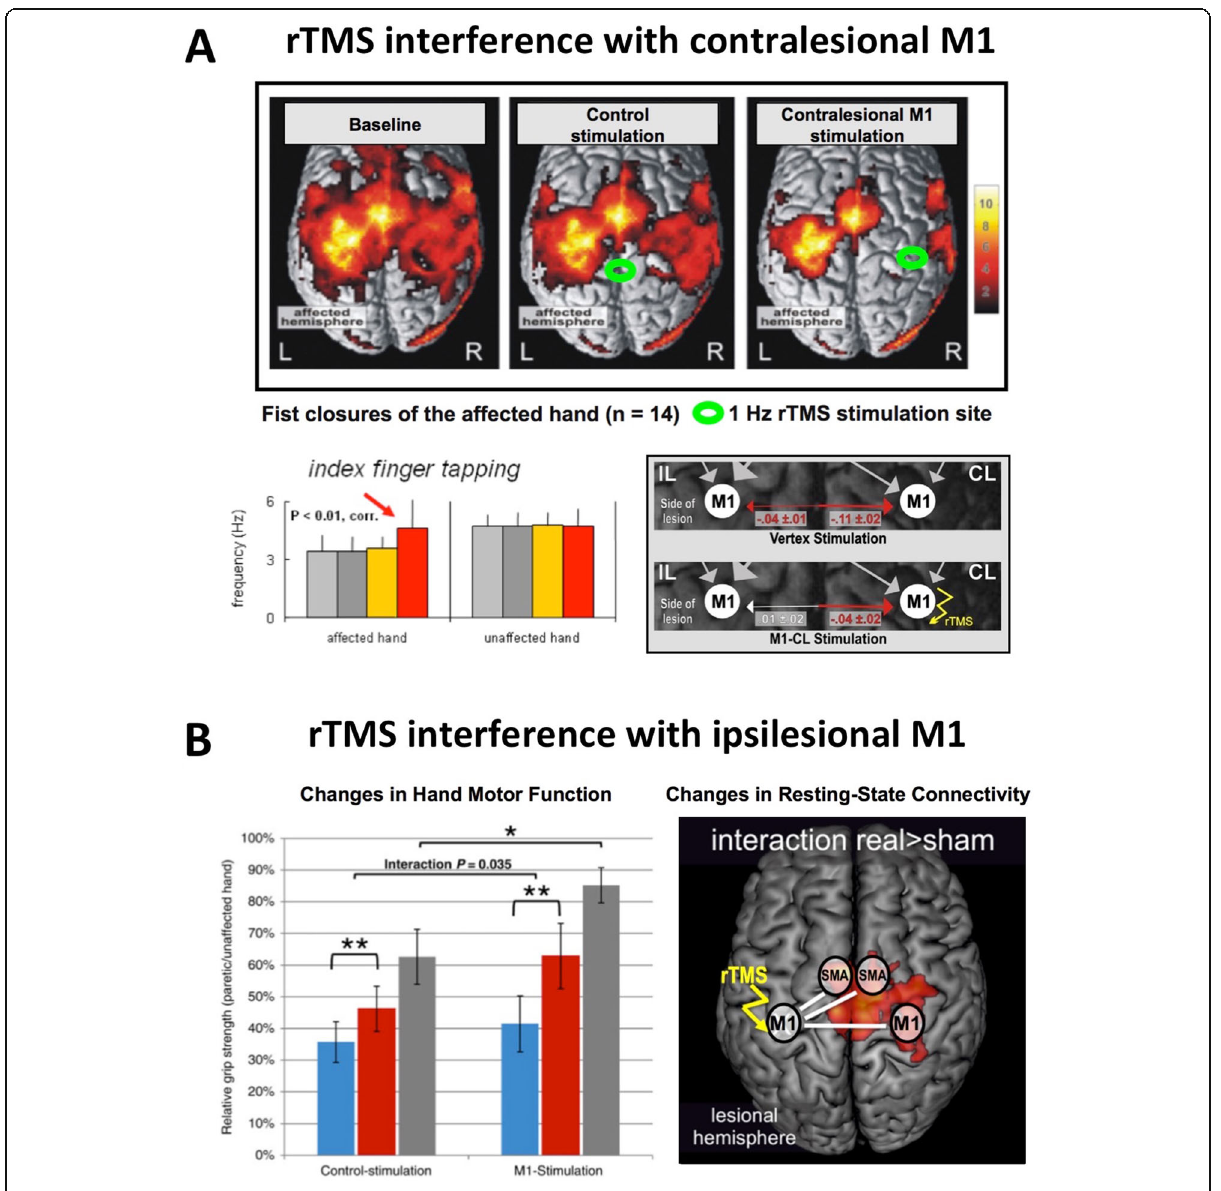
Fig. 4 Shaping brain networks post-stroke using non-invasive brain stimulation. a Application of 1 Hz rTMS to suppress contralesional M1 activity leads to normalization of brain activity associated with movements of the stroke-affected hand. Connectivity analyses reveal that inhibitory influences originating from M1 of the unaffected hemisphere disappear after 1 Hz treatment compared to baseline measurement or sham stimulation. From Grefkes et al. [27], with permissions. b Application of iTBS rTMS to enhance ipsilesional M1 activity in the first weeks after stroke improves recovery of grip strengths (blue: baseline measurement; red: post-intervention measurement; grey: follow-up measurements 3 months later). At the neural level, patients having received iTBS over M1 feature more robust resting-state functional connectivity of the stimulated motor cortex with ipsi- and contralesional sensorimotor areas. From Volz et al. [72], with